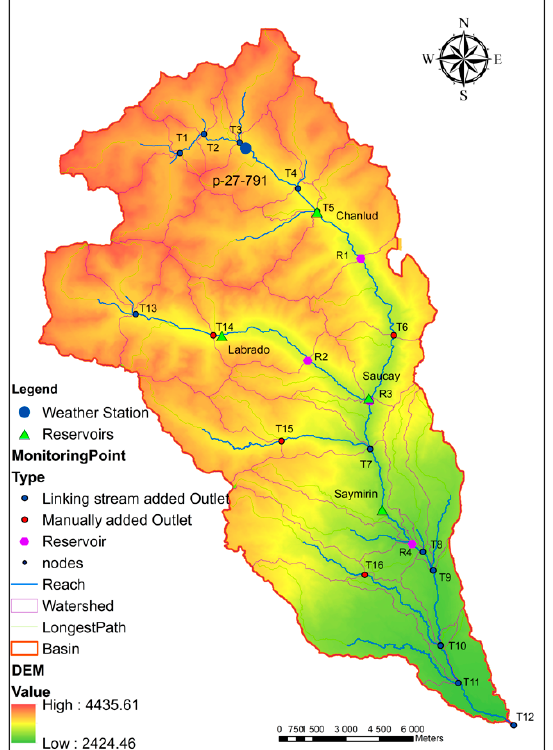
Figure 5. River network configuration for the Machágara Basin with the location of the virtual weather station.